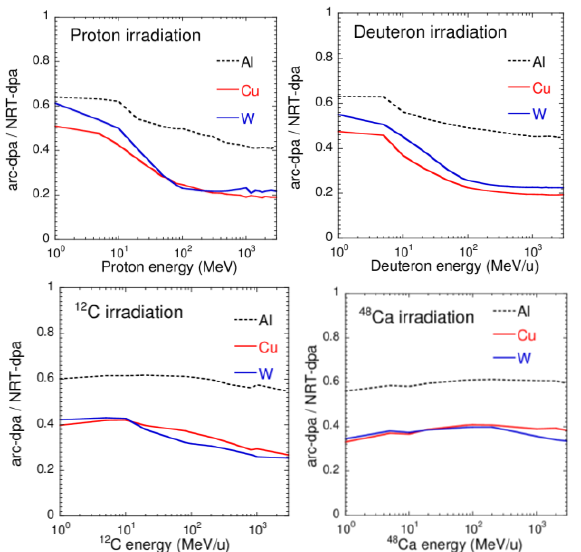
Figure 5 . arc-dpa cross sections for proton, deuteron, 12 C and 48 Ca